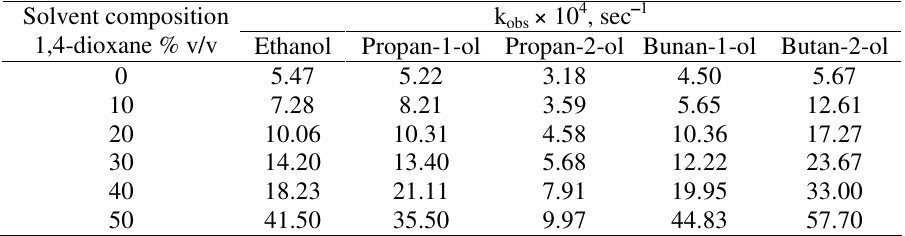
Table 3. Variation of rate with solvent